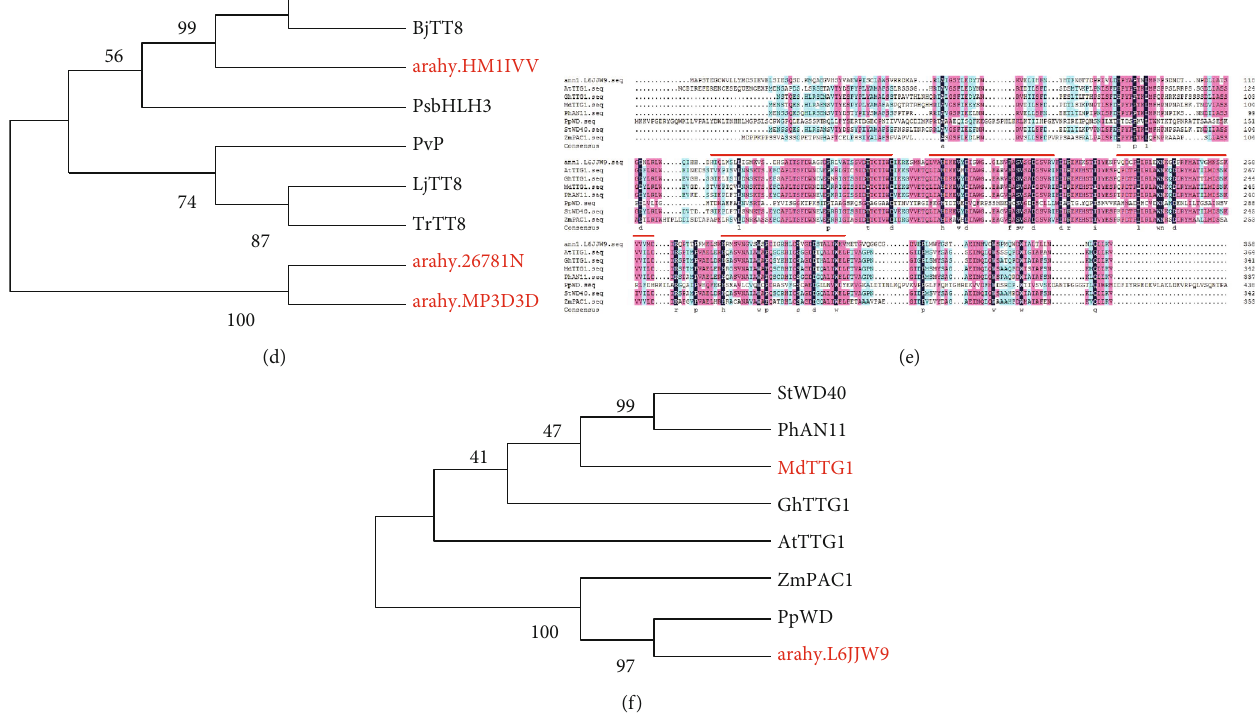
Figure 5: Phylogenetic analysis of MYBs, bHLHs, WD40, and their homologous proteins. (a, c, e) Phylogenetic analyses of peanut MYBs bHLHs and WD40 in other plants. (b, d, f) Multiple alignments of deduced amino acid sequences of peanut MYBs bHLHs and WD40 proteins with other functionally characterized MYBs bHLHs and WD40. R2R3 motif, C-terminal basic-helix1-loop-helix2, and WD-repeat domains were indicated at the